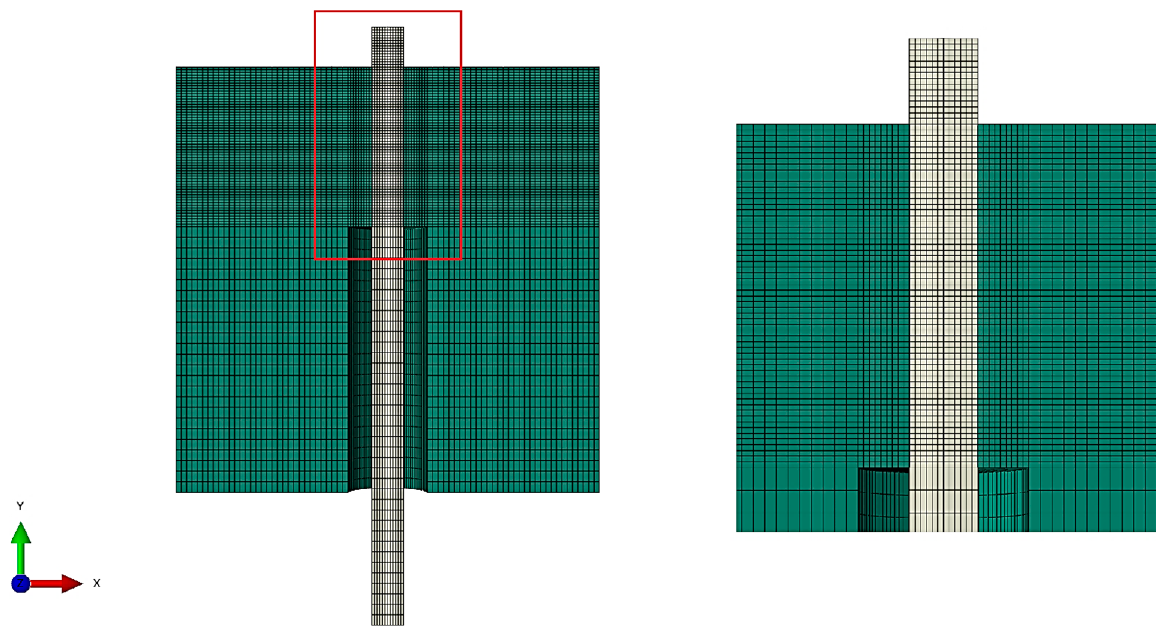
Figure 9. Finite element mesh for POT-12 specimen in ABAQUS.